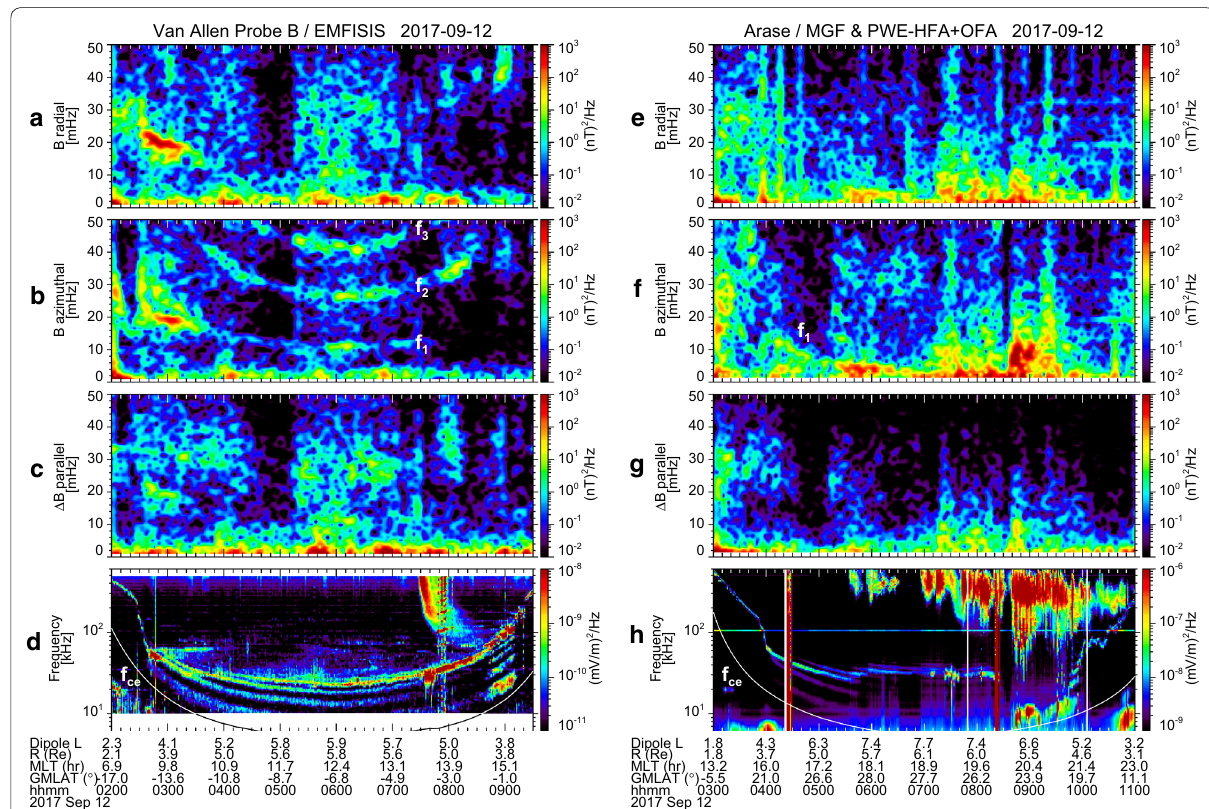
Fig. 2 a – d Van Allen Probe B observations during 02:00–09:30 UT on 12 September 2017. The top three panels display the dynamic power spectra of the magnetic field variations in the radial, azimuthal, and compressional components measured by EMFISIS. In b , a harmonic structure of wave power enhancement is labeled f 1 (fundamental mode), f 2 (second harmonic mode), and f 3 (third harmonic mode). The bottom panel shows the plasma wave spectrogram for the electric field measured by EMFISIS. A white/black line delineates the local cyclotron frequency of electrons ( f ce ). e – h Arase observations during 03:00–11:00 UT on 12 September 2017. The format is the same as a – d except that the magnetic field data are obtained by MGF and the plasma wave spectrogram for the electric field is obtained by PWE-HFA and